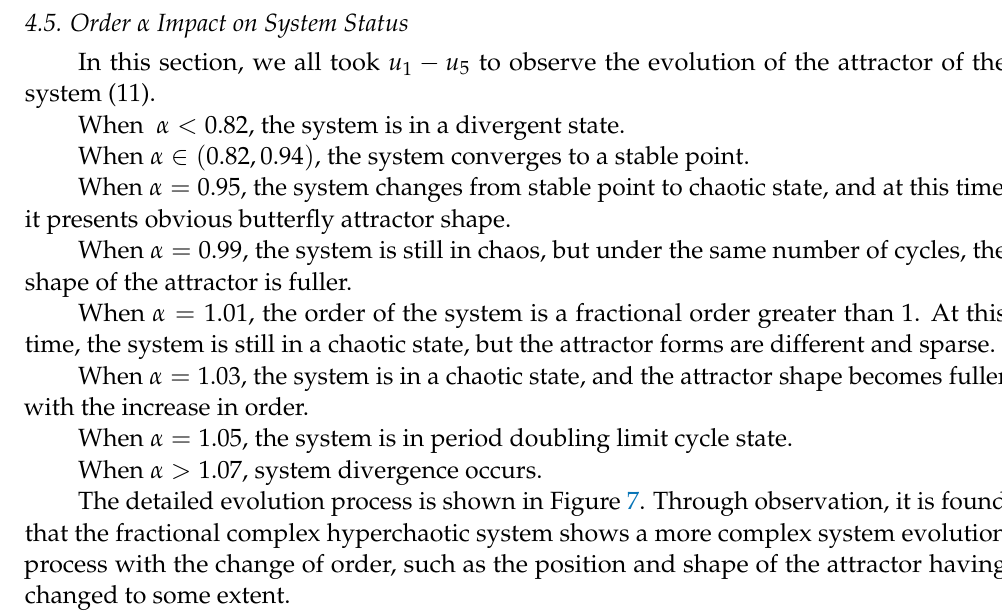
Figure 6. The “0 - 1”test.